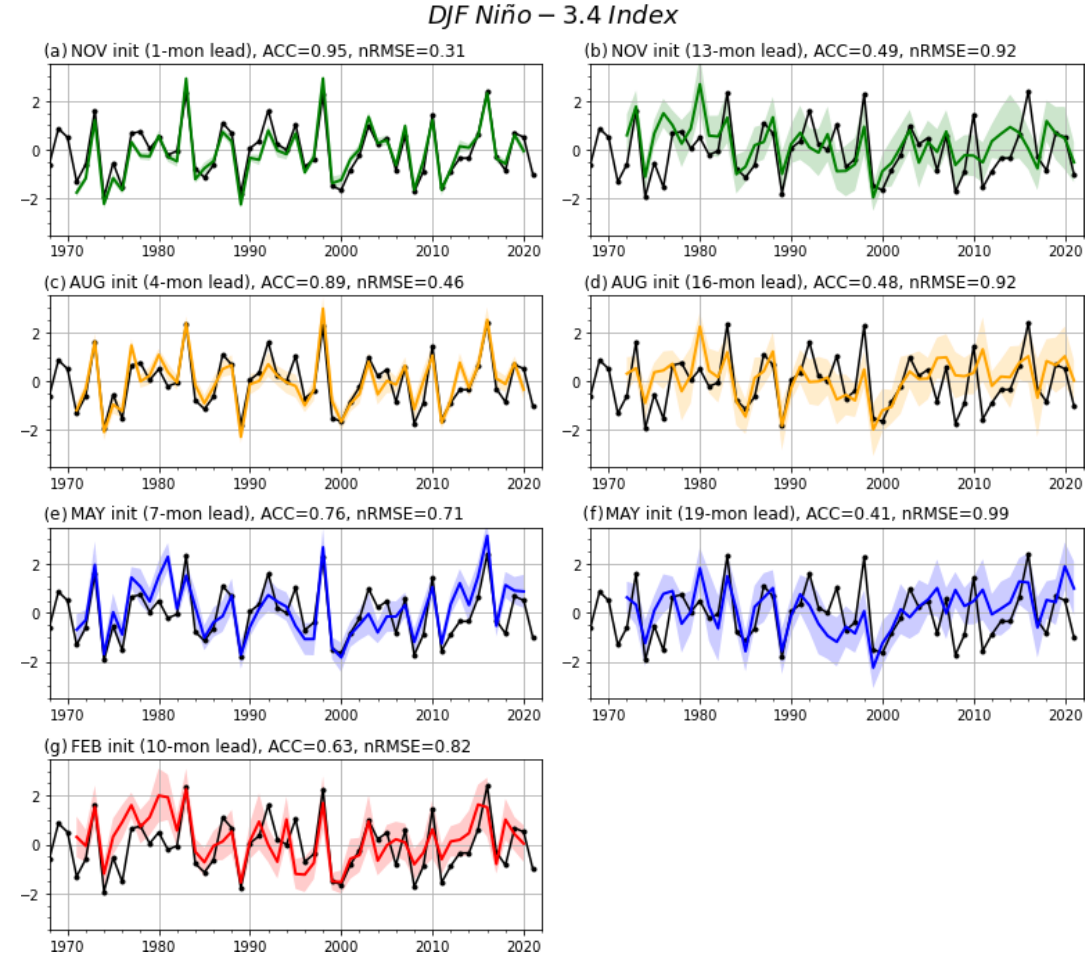
Figure 4. Time series of DJF Niño-3.4 index in observations (black curve; HadISST1) and SMYLE hindcasts at seven different lead times. Colored curves show the SMYLE ensemble mean, and shading shows ensemble spread ( ± 1 standard deviation). The ACC and normalized RMSE scores are given at the top of each panel. The x axis reflects the year of January (e.g., DJF 2020 represents the average for